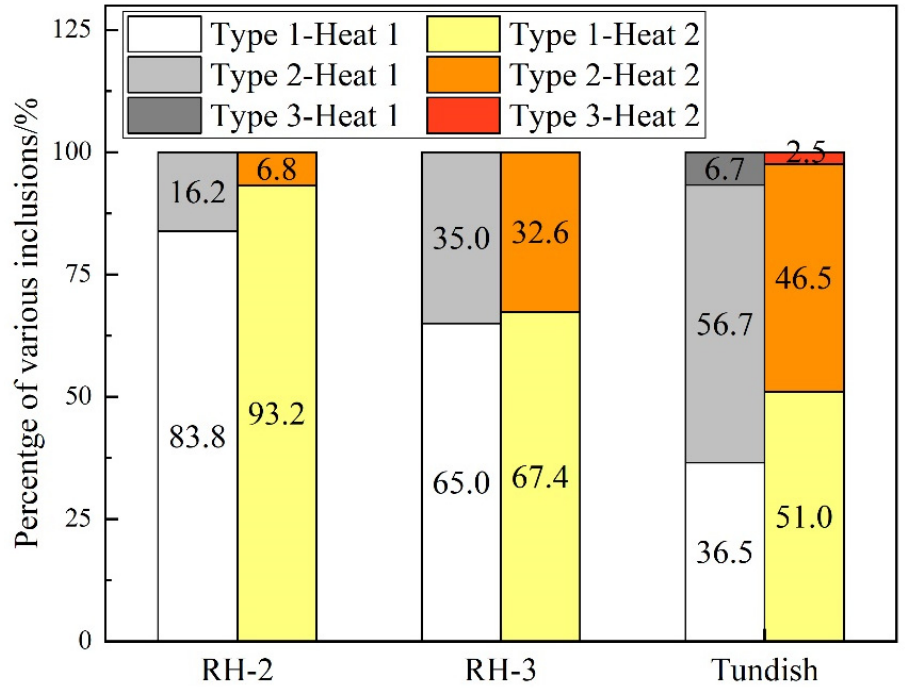
Figure 10. Percentage of various Al 2 O 3 · TiO x inclusions during RH treatment and tundish processes. The Ti/Al ratio in various Al 2 O 3 · TiO x inclusions during RH treatment and tundish processes is presented in Figure 11. During the whole steelmaking process, the Ti content in Type 2 and Type 3 inclusions is significantly larger than that in Type 1 inclusions, and the Ti and Al contents in Type 1 inclusions almost keep constant. During RH treatment, the Ti and Al contents in Type 2 inclusions have a small fluctuation. After arriving at tundish, the Ti/Al ratio in Type 2 inclusions increases significantly owing to the increase in Ti content. In the tundish sample, the Ti/Al ratio of Type 3 inclusions among the three types of Al 2 O 3 · TiO x inclusions reaches the maximum, indicating that the relative Ti content in Type 3 inclusions is at the largest level. Additionally, the Ti/Al ratio of Type 2 and Type 3 inclusions in the tundish sample of Heat 2 is larger than that in the tundish sample of Heat 1. This indicates that the Ti content in Type 2 and Type 3 inclusions will increase obviously when the molten steel encounters serious